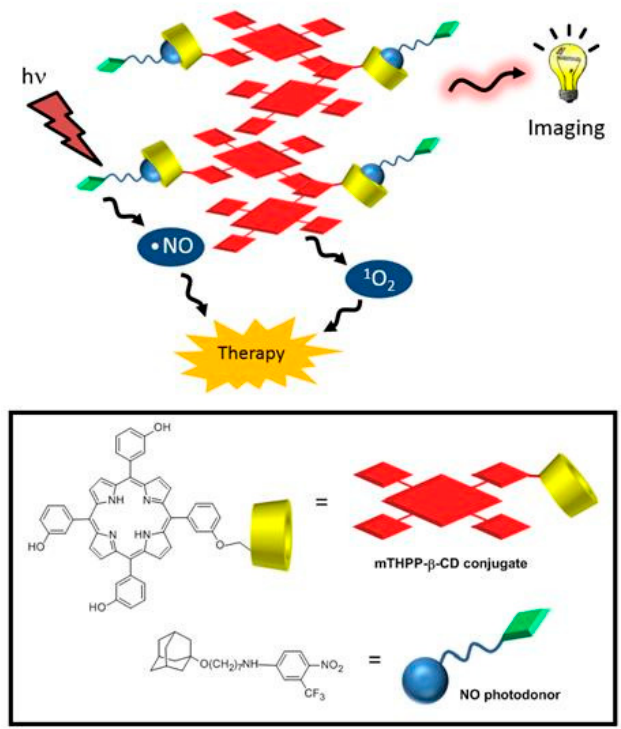
Figure 27. Schematic representation of the photoresponsive supramolecular nanoaggregate. Adapted from Fraix; Goncalves; Cardile; Graziano; Theodossiou; Yannakopoulou; Sortino [145].